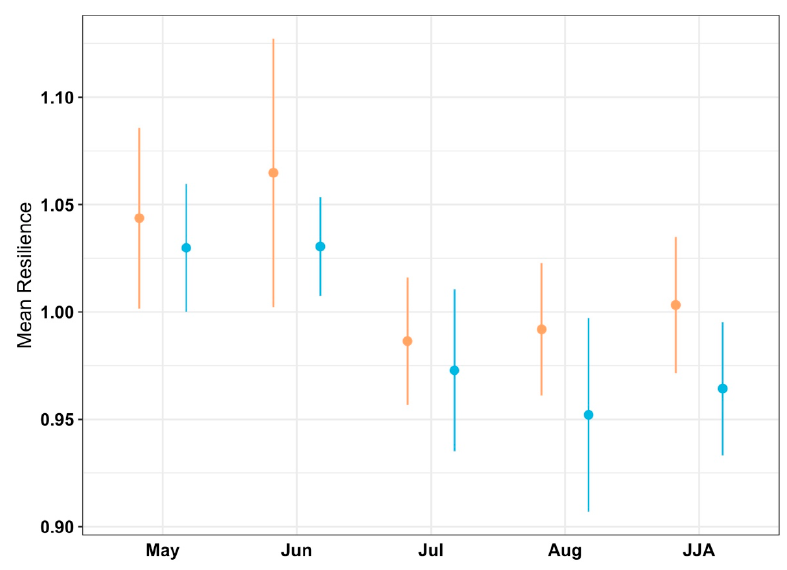
Figure 4. Mean growth resilience to drought (SPEI ≤ − 1.5) with 95% con fi dence interval of co-occurring Carya ovata (orange) and Quercus alba (blue) chronologies of individual months and June − July– August (JJA) of current growing season at 15 study sites.